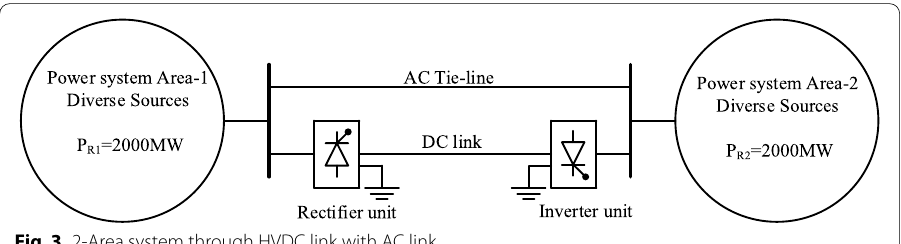
Fig. 3 2-Area system through HVDC link with AC